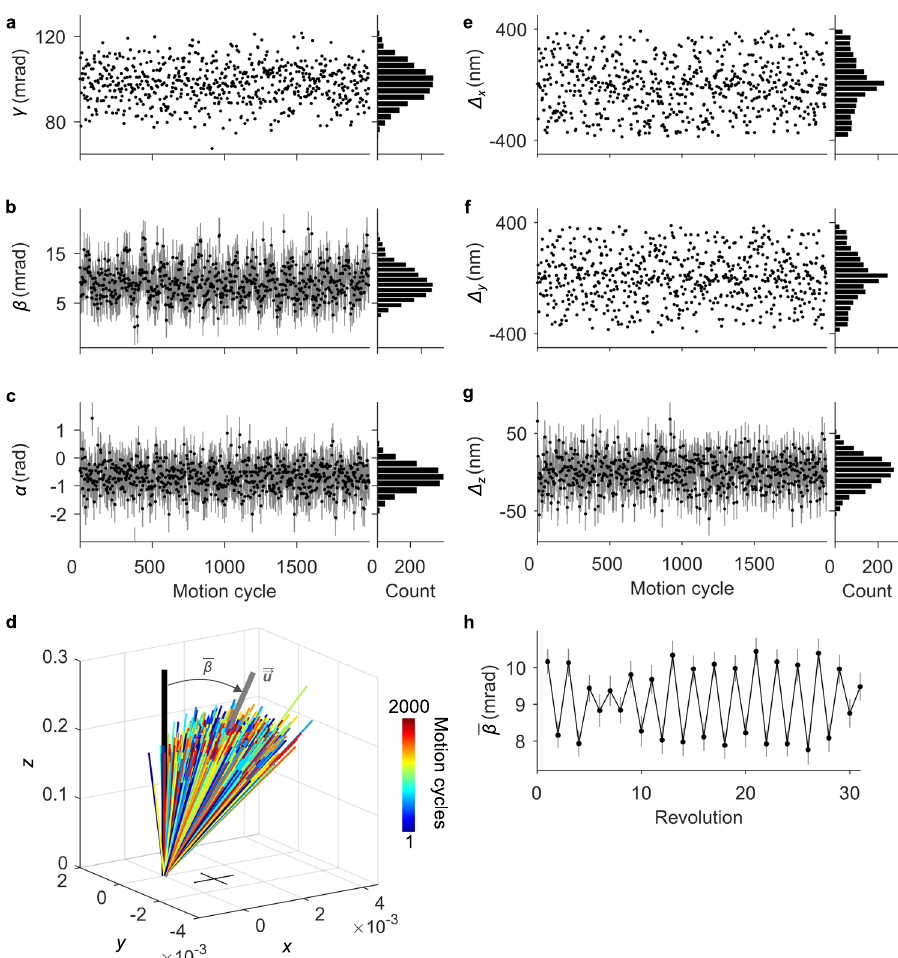
Fig. 8 Microsystem motion in six degrees of freedom. a – c Plots and histograms showing ( a ) intrinsic rotations of the load gear in three-dimensional space γ , ( b ) the angle between the axis of rotation and the extrinsic z axis, or nutation β , and ( c ) the angle between the axis of rotation and the extrinsic x - z plane, or precession α . d Plot showing lines in the direction of (colors) the axis of rotation for each motion cycle, (gray) the mean axis of rotation, and (black) the extrinsic z axis. The cross denotes uncertainties. e – g Plots and histograms showing translation of the load gear in the ( e ) x , ( f ) y , and ( g ) z directions. h Plot showing the mean nutation (cid:2) β with a reciprocating rotation with each revolution of the load gear. Uncertainties are ( a , e , f ) smaller than data markers, ( h ) 68 % coverage intervals, and ( b , c , g ) as we describe in the Methods. a – c , e – g © 2020 IEEE. Reprinted, with permission, from Ref. 32